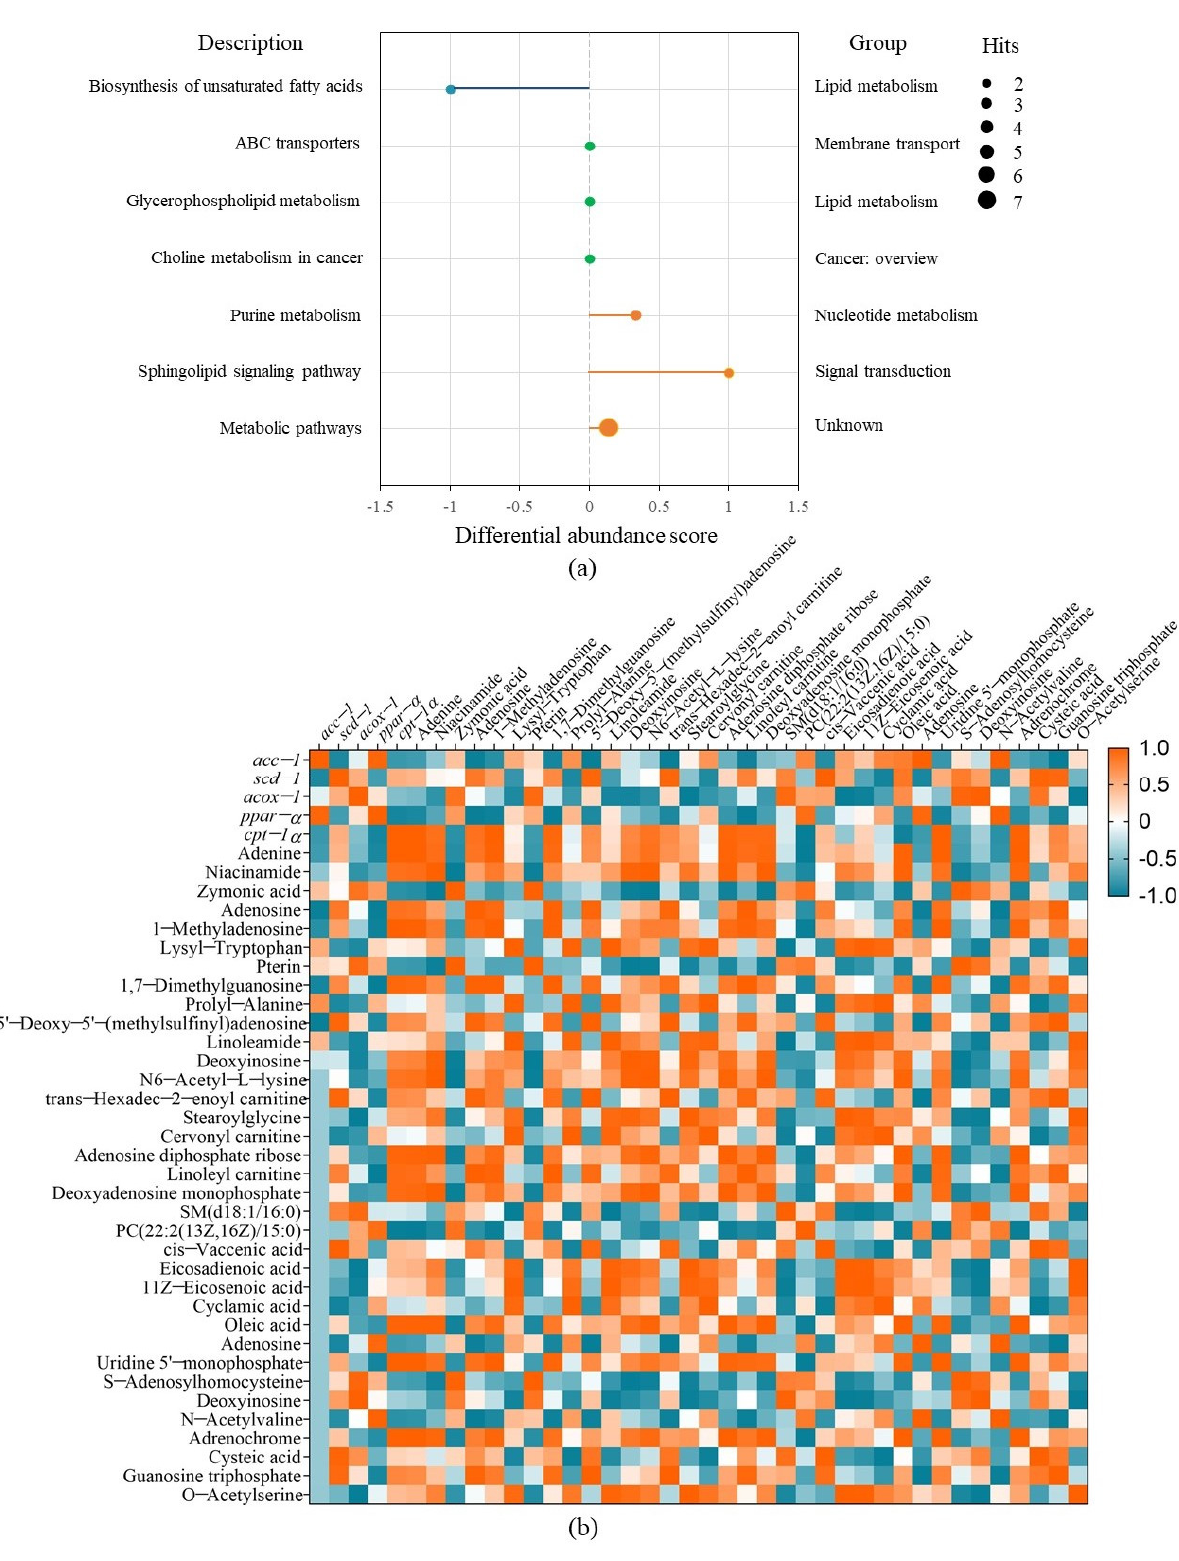
Figure 6. The differential abundance score diagram of FBBE-PS group vs. the model group for metabolic pathway analysis ( a ) and the correlation analysis between metabolites and lipid metabolism genes ( b ).